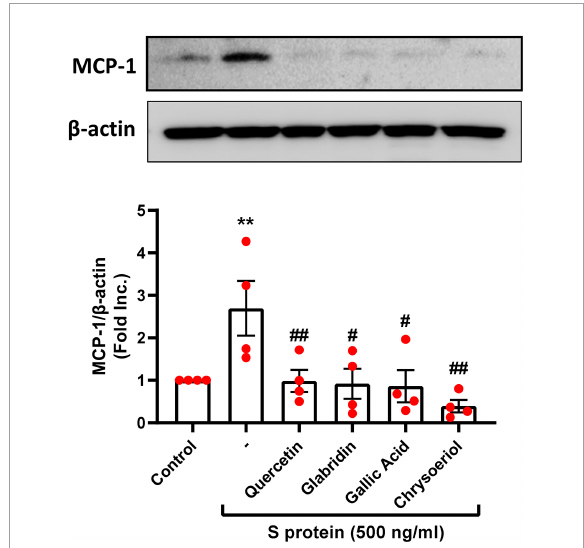
FIGURE5 Attenuation of SARS-CoV-2 spike protein-induced upregulation of MCP-1 by quercetin, glabridin, gallic acid, and chrysoeriol. Bovine aortic endothelial cells (BAECs) were pretreated with viral spike protein (S protein, 500 ng/ml) for 30 min before exposure to 100 nmol/l of small molecule compounds for 24 h. Shown are representative Western blots and grouped data of MCP-1 protein expression indicating upregulation of proinflammatory protein MCP-1 by S protein, which was completely attenuated by small molecules. Data are shown as mean ± SEM. n = 4. ** p < 0.01 vs. control group; # p < 0.05, ## p < 0.01 vs. S protein treated group by one-way